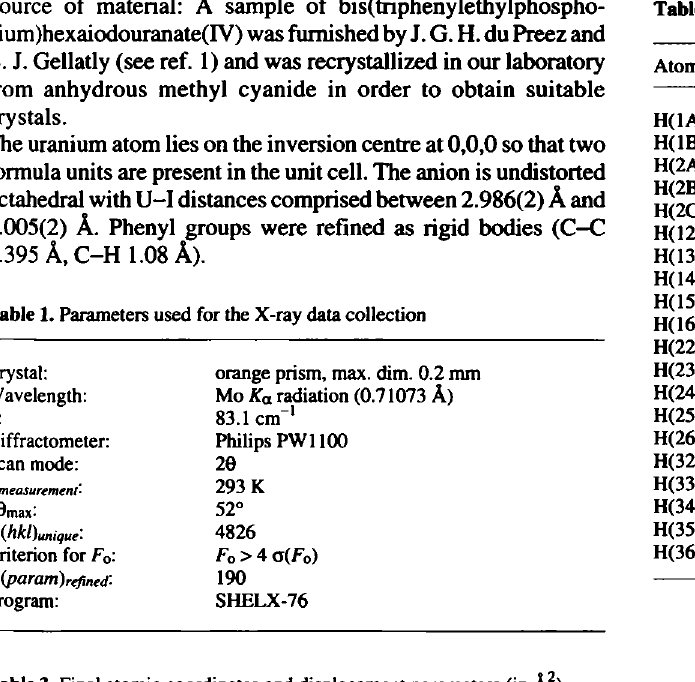
Table 3. Final atomic coordinates and displacement parameters (in